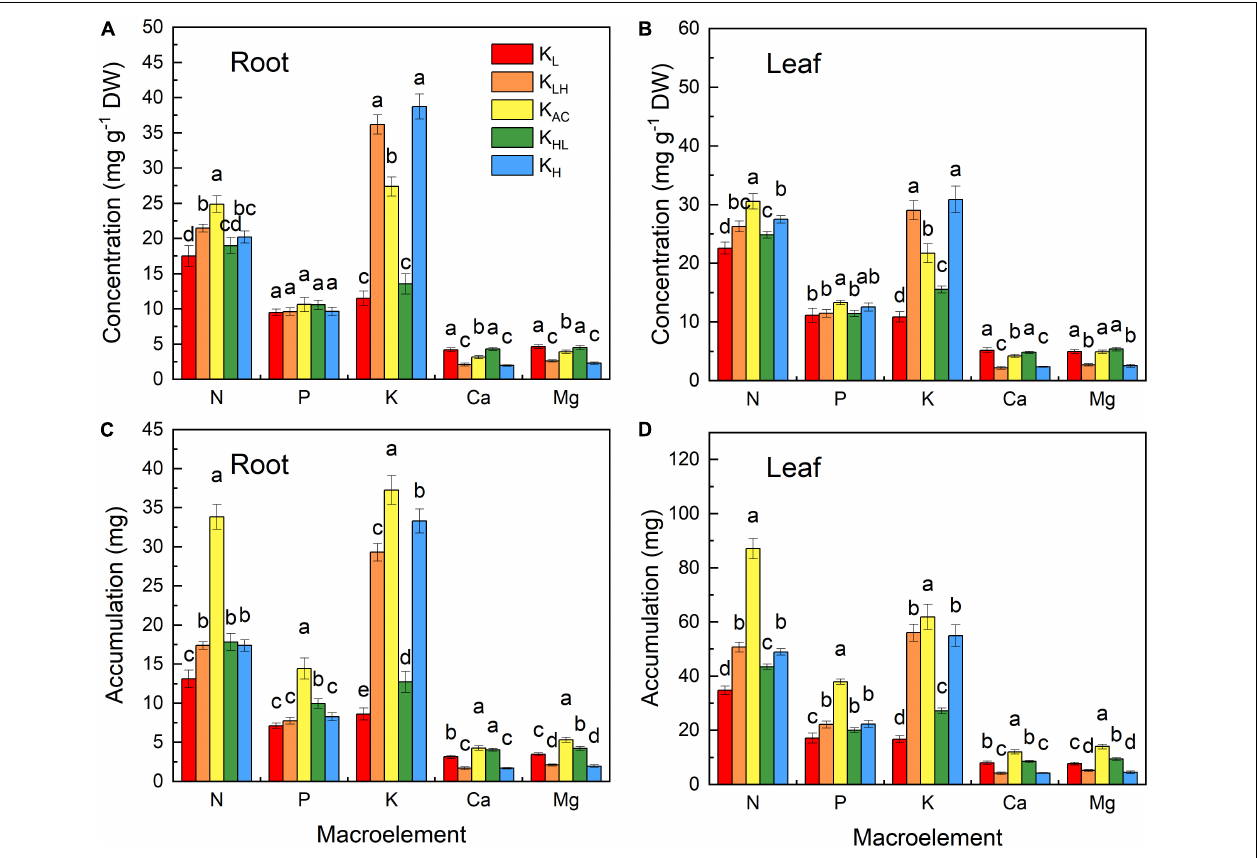
FIGURE 3 | Effect of different K treatments on element contents in roots (A) and leaves (B) ; element accumulation in roots (C) and leaves (D) of M9T337 rootstocks. Data show the means ± standard deviation of three independent samples. Different letters on vertical bars indicate significant differences ( P <